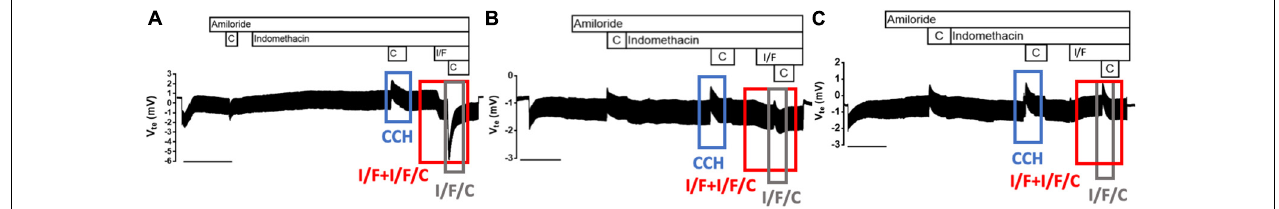
FIGURE 1 | Representative original tracings from Ussing chamber measurements of CFTR-mediated Cl - secretion in rectal biopsies from 143 individuals with three distinctive patterns. Effects of cholinergic stimulation by carbachol (CCH, 100 µ M, basolateral, blue box), cAMP-dependent by IBMX/Forskolin (I/F, 100 µ M/2 µ M, basolateral), and I/F/C combined on transepithelial voltage (V te ) represented by the red box, on rectal biopsies from: (A) non-CF individuals, (B) individuals with atypical CF, and (C) individuals with classical CF. The gray box represents the effect of the last I/F/C response. Experiments were performed in the presence of Amiloride (Amil, 20 µ M, luminal) and/or Indomethacin (Indo, 10 µ M, basolateral), as indicated above